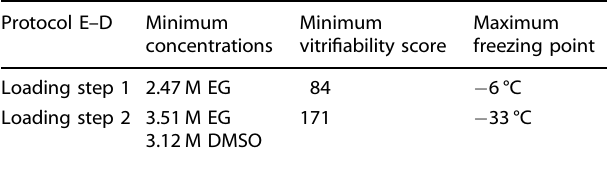
Table 1. Minimum cryoprotectant concentrations and vitri fi ability scores and maximum freezing point calculated at the end of each loading step in Protocol E – D – P (located at the center of the cartilage cube where x = 0 mm).